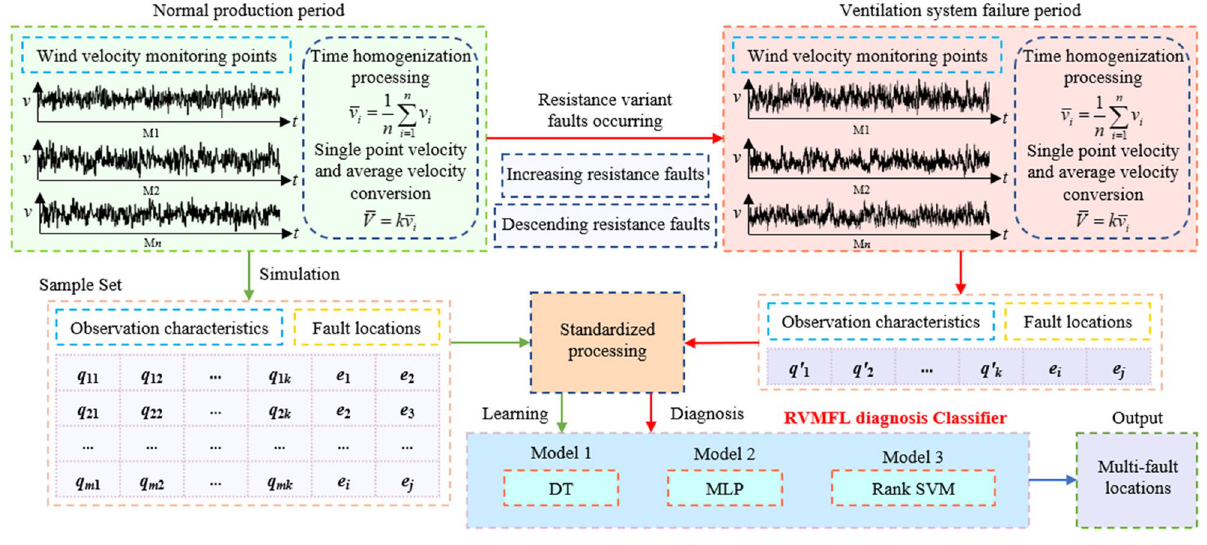
Figure 2. Ventilation system RVMFL diagnosis method